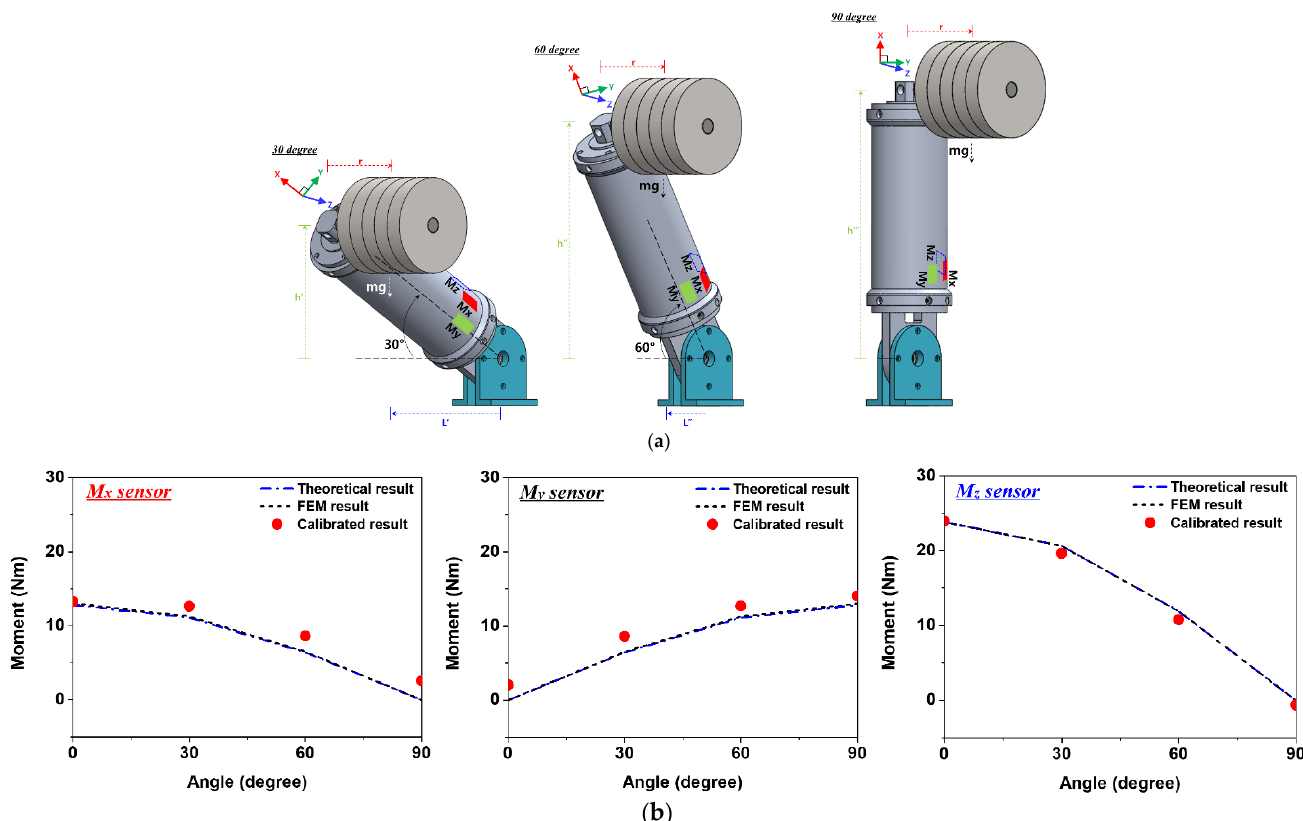
Figure 7. External force estimation result of three-axis sensor considering the slope of link. ( a ) Sche- matics of experiments. ( b ) External force estimation result considering the slope of the link.